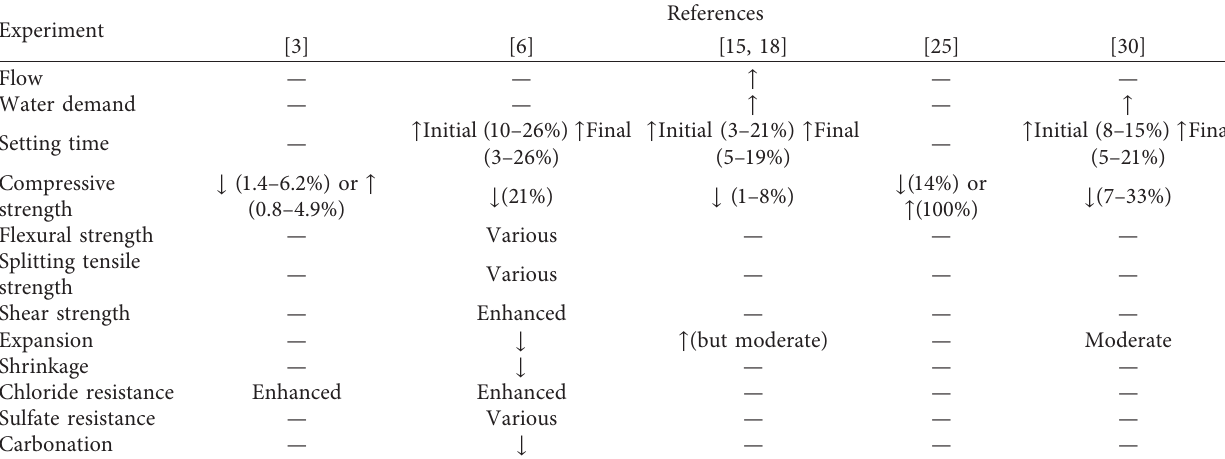
Table 3: Summary of results for the incorporation of FNS in Portland cement as a binder.